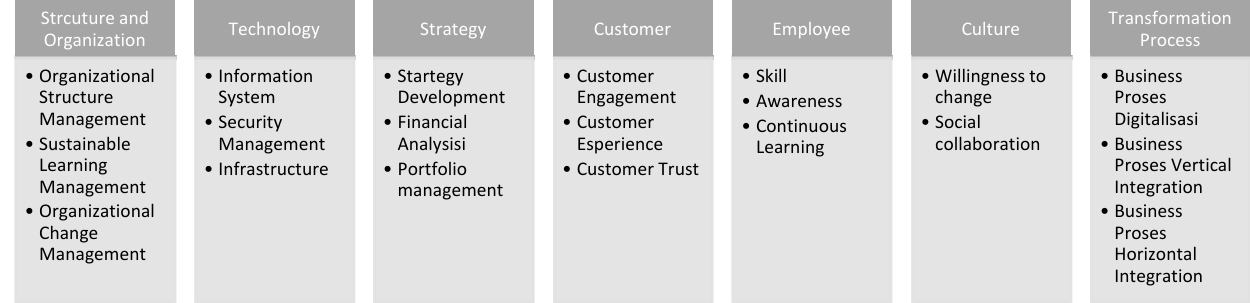
Figure 3. Extended Framework of Digital Maturity.